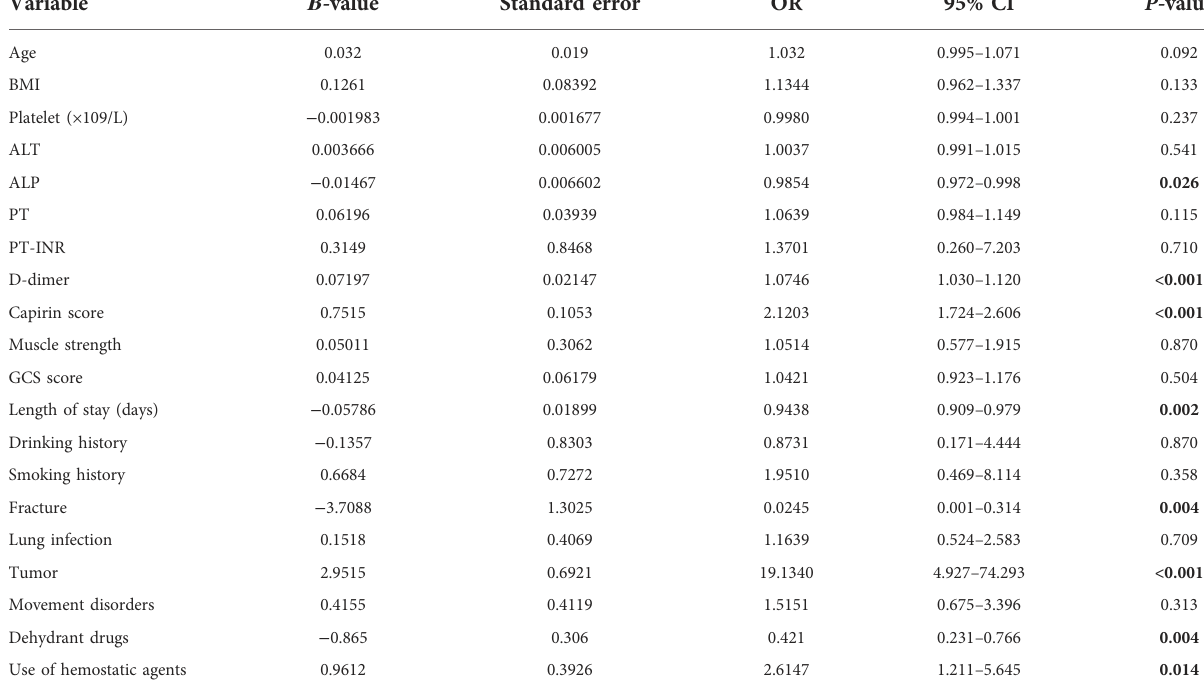
TABLE 2 Multivariate